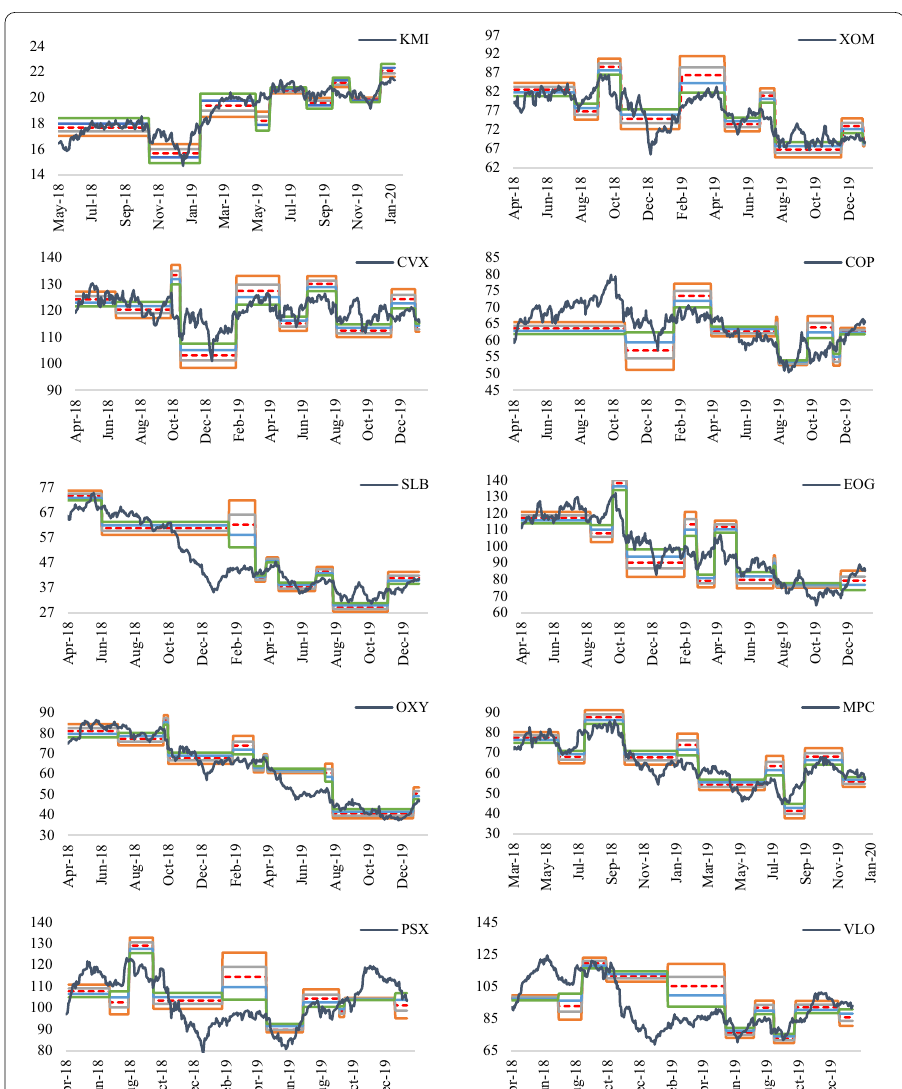
Fig. 8 Energy stock prices and Fibonacci retracements. Note : This figure represents the 23.6%, 38.2%, 50%, 61.8% and 78.6% (the colour codes are provided in Fig. 7) Fibonacci retracement levels for the leading U.S. energy stock prices over the period November 2017–January